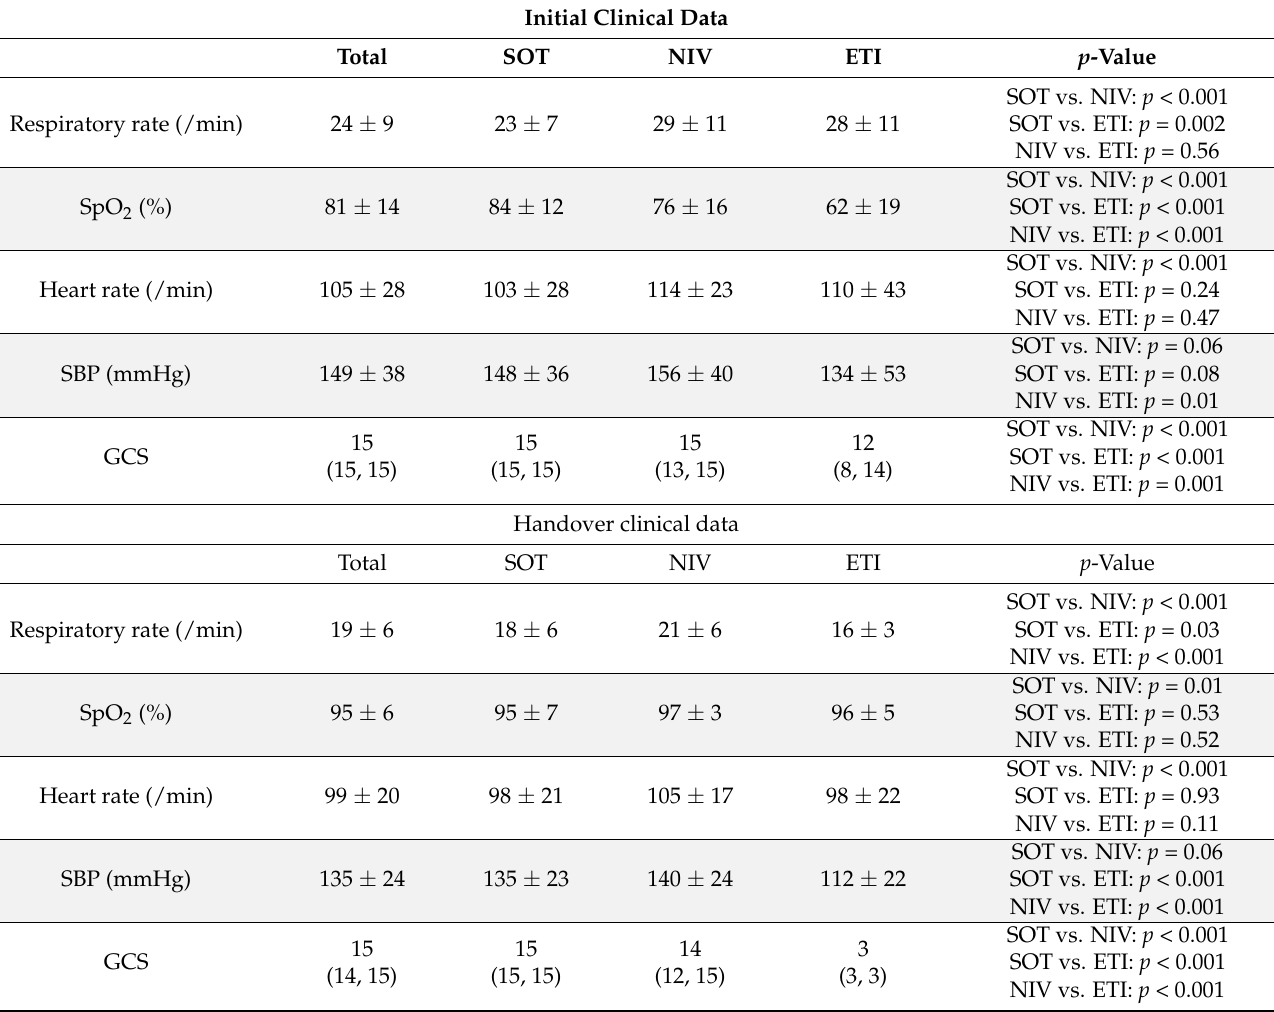
Table 2. Initial and handover clinical